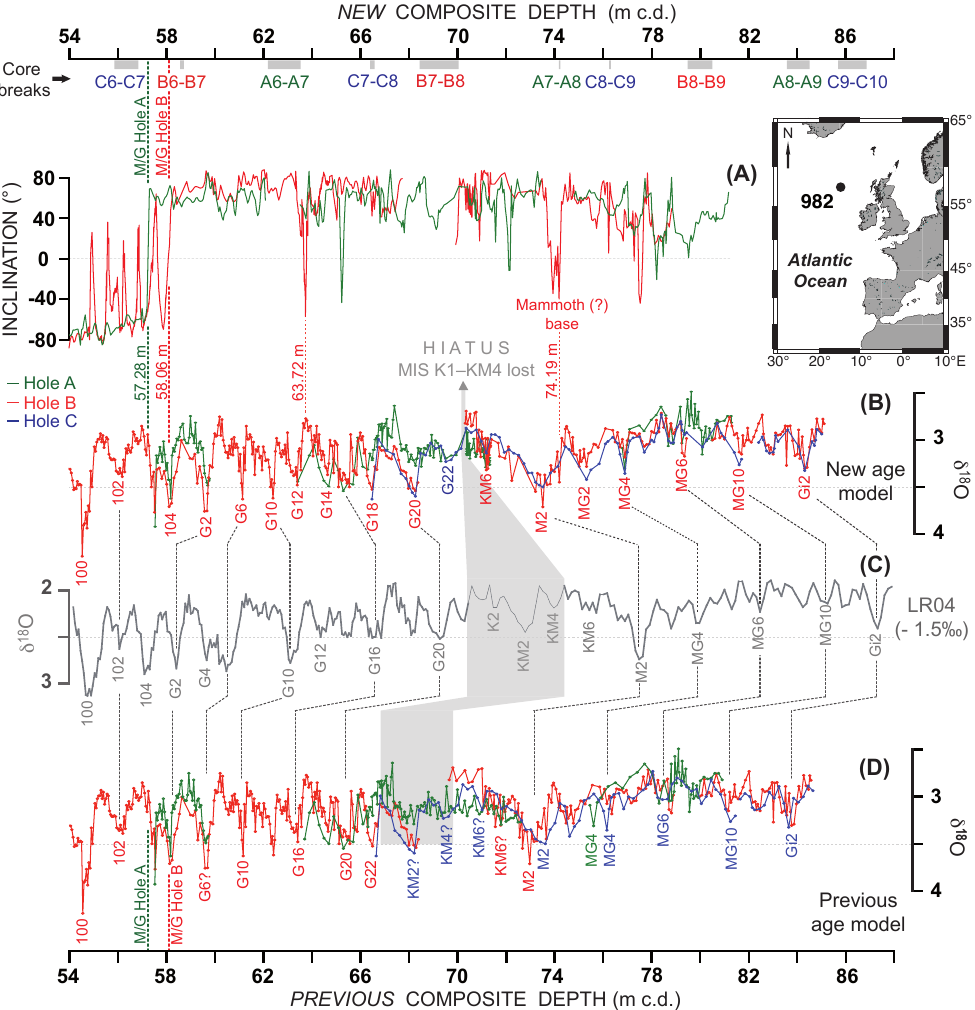
Fig. 1. Different models of age control for ODP Site 982 (location shown at inserted map). (A) Magnetic polarity reversals are from the shipboard inclination data for holes A (green) and B (red) (Channell and Lehman, 1999; Channell and Guyodo, 2004), plotted on new composite depth (c.d.) scale. M/G=Matuyama/Gauss. (B) Benthic δ 18 O records of holes 982A, B, and C, plotted over the new c.d. scale (data of Venz and Hodell, 2002; suppl. by Lisiecki and Raymo, 2005, and by this study, as specified in Table S1; see Supplement; Fig. S1). Labeled isotope stages are tuned (hatched lines) to (C) benthic δ 18 O stack LR04 (Lisiecki and Raymo, 2005). (D) Benthic δ 18 O records of holes 982A, B, and C plotted over the “previous age model” of the Shipboard Scientific Party (1996), as cited by Lawrence et al. (2009). Small grey bars near the top depth scale mark potential losses of sediment sections at core breaks, which differ on the old and new composite depth scales below 68.36m c.d. The two different c.d. scales for the δ 18 O records in holes A, B, and C lead to major age discrepancies at 58–72 (new) m c.d. Major grey bar near 70 m (new) c.d. constrains the stratigraphic interval in LR04, which is lost in a hiatus as a result of the new age